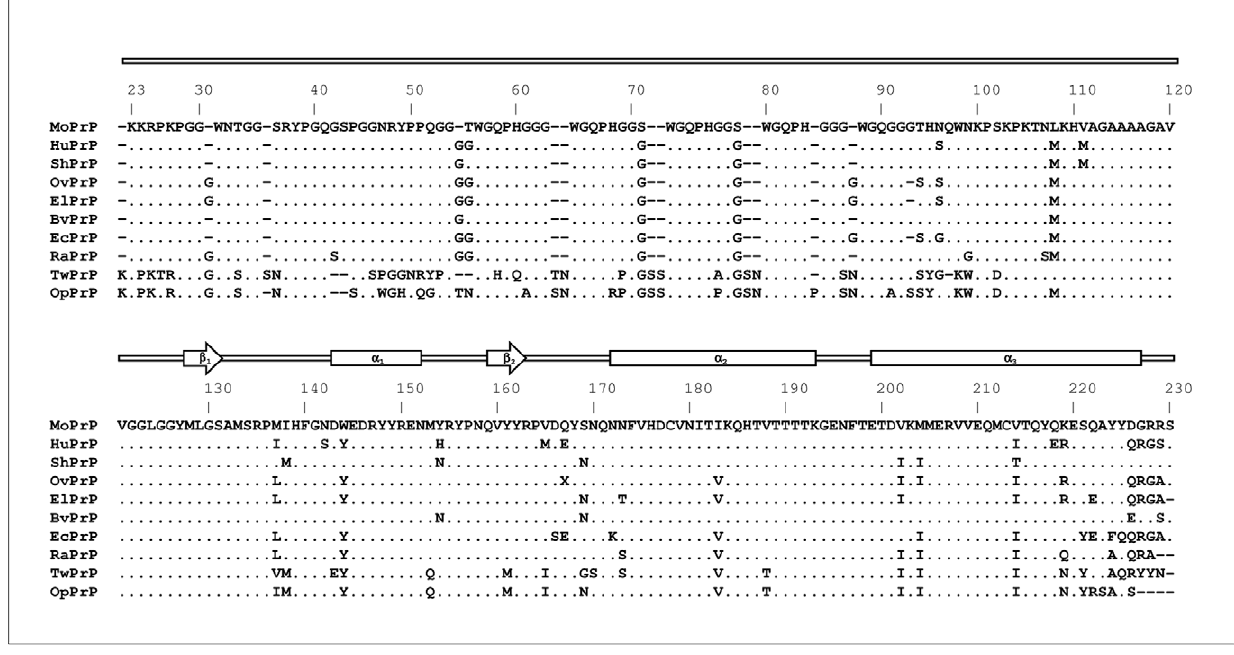
Figure 1. Comparison of amino acid sequences and secondary full-length prion protein structure of selected mammalian species: mouse (MoPrP; Musmusculus , GenBank accession number: AAA39997), human (HuPrP; Homosapiens , AAA60182), Syrian hamster (ShPrP; Mesocricetusauratus , AAA37091), sheep (OvPrP; Ovisaries , ABC61639), elk (ElPrP; Cervuselaphusnelsoni , AAB94788), bank vole (BvPrP; Clethrionomys glareolus , AAL57231), horse (EcPrP; Equus caballus , ABL86003), rabbit (RaPrP; Oryctolagus cuniculus , AAD01554), tammar wallaby (TwPrP; Macropuseugenii , AAT68002) and opossum (OpPrP; Monodelphisdomestica , CBY05848).